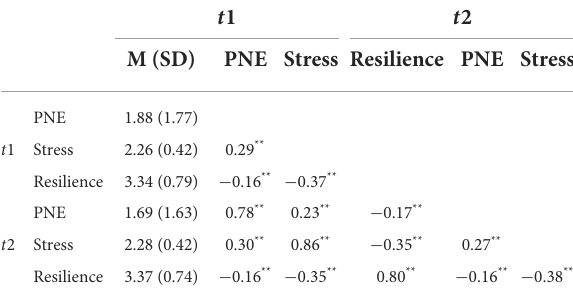
TABLE 2 Descriptive parameters and correlation coefficients a for the relevant